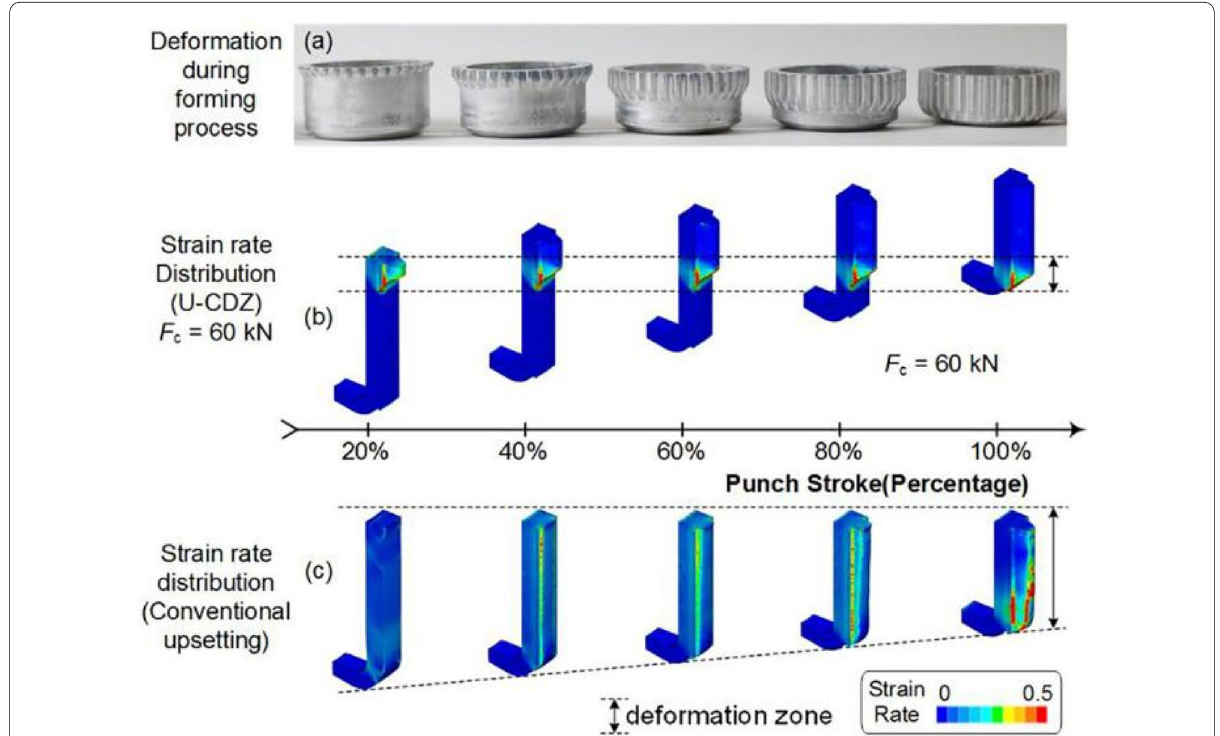
Figure 11 Deformation mechanism of bulk forming process: ( a ) evolution of workpiece during forming process, ( b ) strain rate distribution based on U-CDZ method, ( c ) strain rate distribution based on conventional upsetting